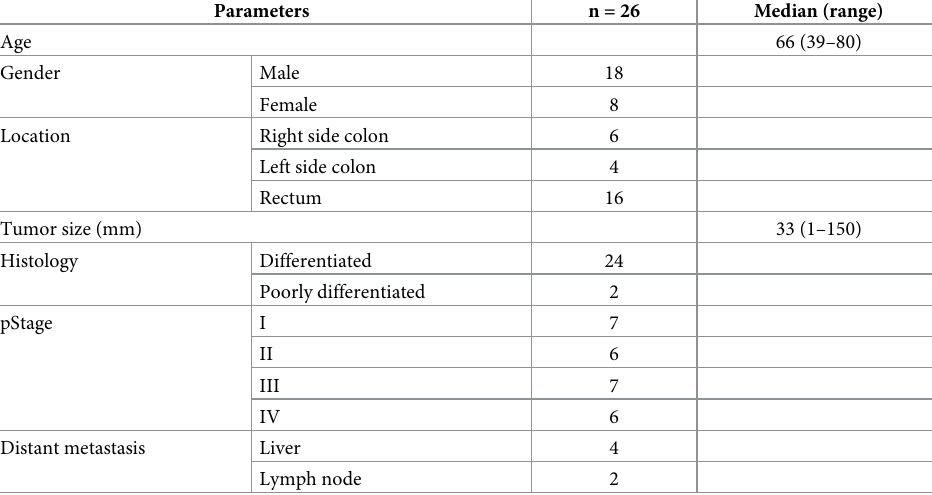
Table 1. Patient’s